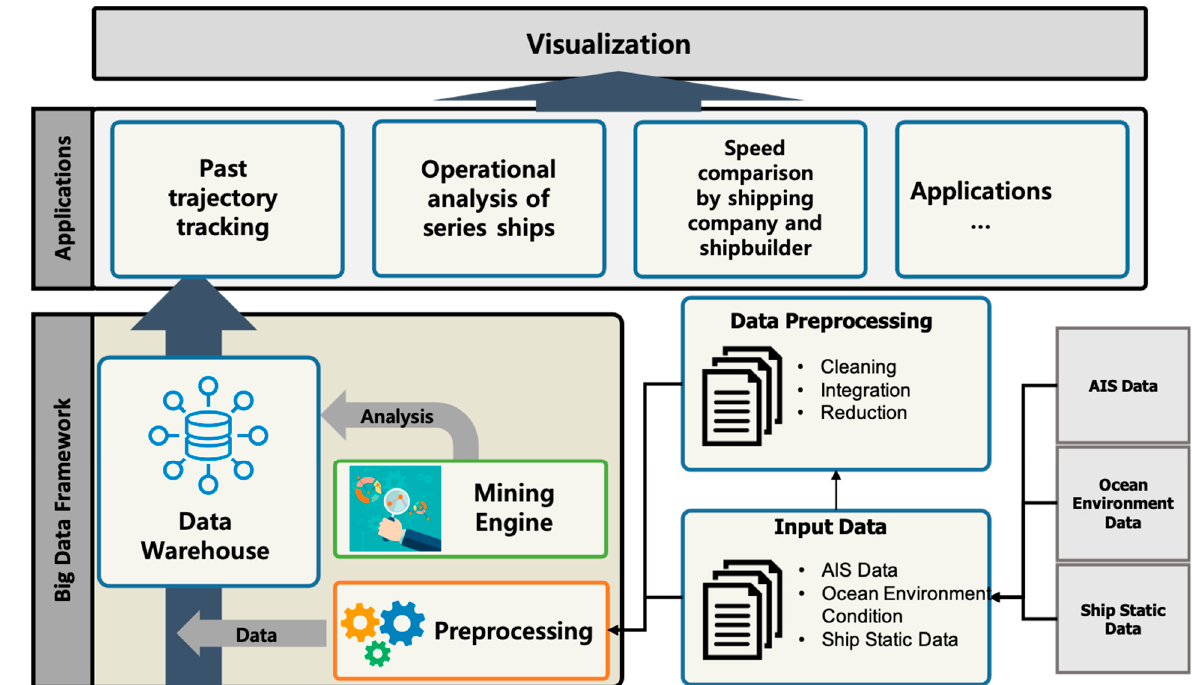
Figure 1. Configuration of the big data framework for operational analysis.